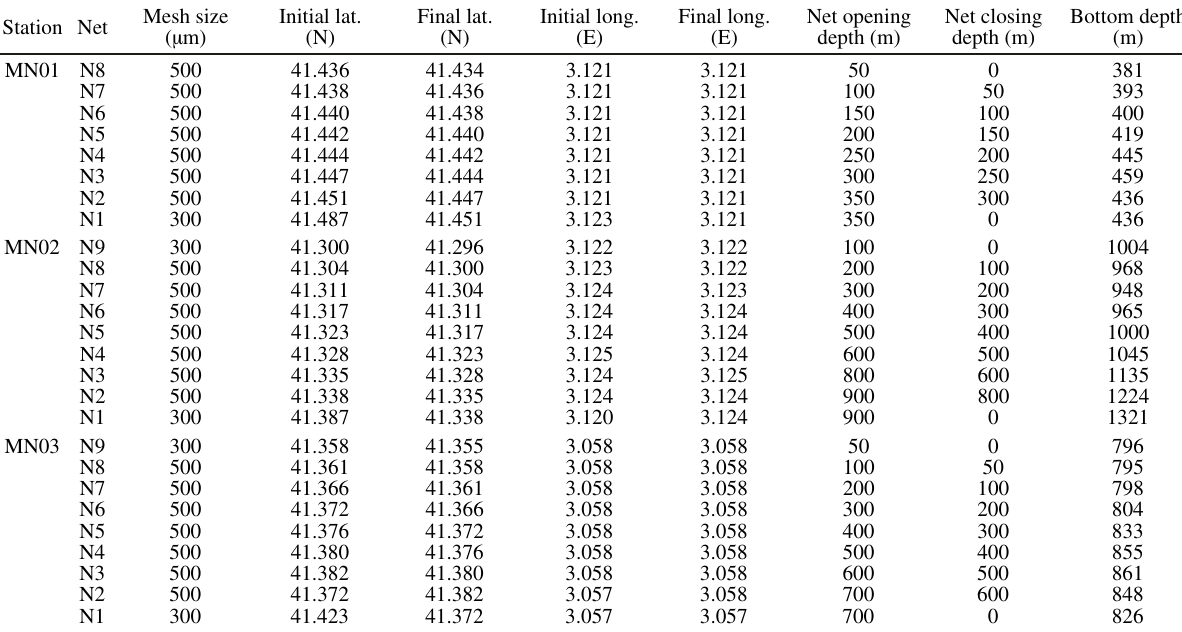
Table 2. – Information on the stations sampled with the MOCNESS